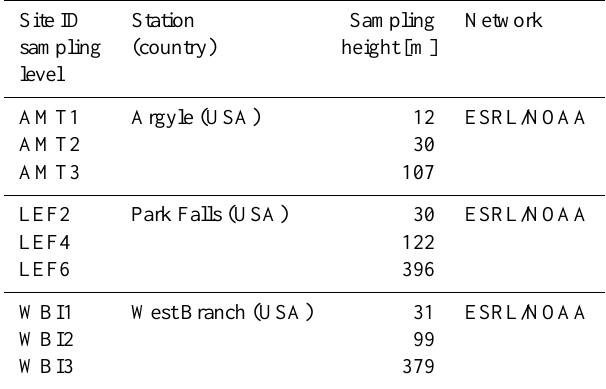
Table 3. Sampling heights at the tall towers listed in Table